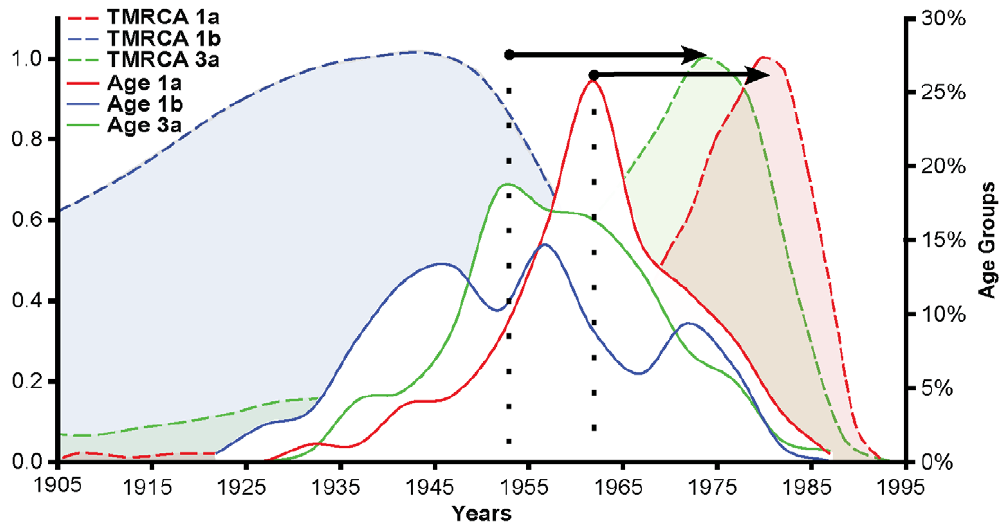
Figure 3. Viral and host age structure. Dotted color-filled distributions at the back of the figure show the relative densities of estimates of the Time to the Most Recent Common Ancestor (TMRCA) of HCV-1a (red), HCV-1b (blue) and HCV-3a (green). The TMRCA relative densities (left y -axis) depict the frequency normalized to unity of TMRCA values sampled during the MCMC runs in BEAST. Full line distributions in the foreground show the percentage of HCV carriers that were born in a specific year ( x -axis). Patient age distributions were color-coded in the same fashion as the TMRCA. Horizontal arrows, connecting the mode of age of birth of patients with the TMRCA peak value for both HCV-3a and HCV-1a, show the temporal correlation between each subtype origin of spread and the age of its carriers.